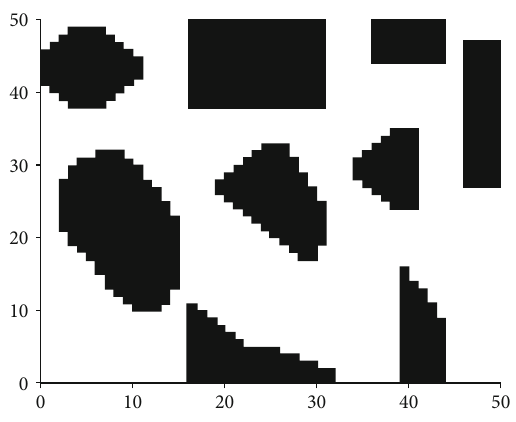
Figure 9: The initial UAV airspace